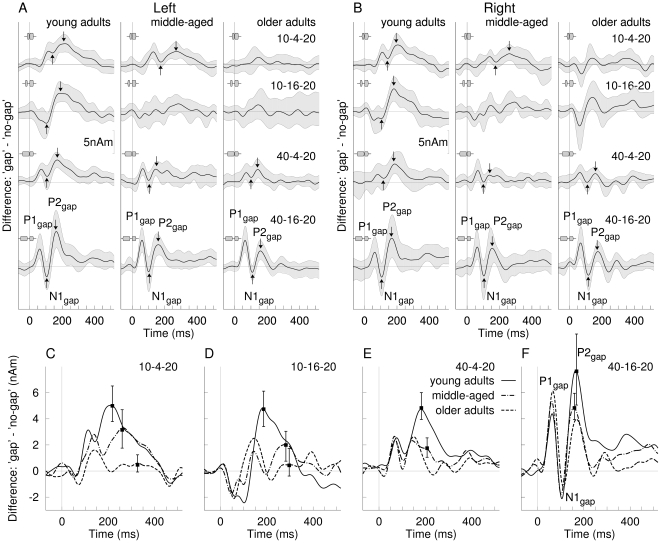
Difference waves between 24-Hz low-pass filtered responses to gap and no-gap stimuli.
A: Comparison of difference waves observed in the left hemisphere between the three age groups. The thick lines represent the group mean difference waves and the gray shaded areas above and below indicate the 95% confidence interval for the group mean. The time scale was adjusted that zero corresponds to the onset of the trailing marker. P1m -N1m -P2m waves can be observed for all age groups in the responses to the 40-16-20 ms stimulus. In general the response size declined with shorter gap duration and shorter duration of the leading marker. Upward arrows point to possible N1gap waves and downward arrows P2gap waves. B: Difference waves in the right hemisphere resembled the left hemispheric responses in wave configuration, amplitudes and latencies. C–F: Overlay of grand mean difference waves across hemispheres for the three age groups and the four stimulus conditions.